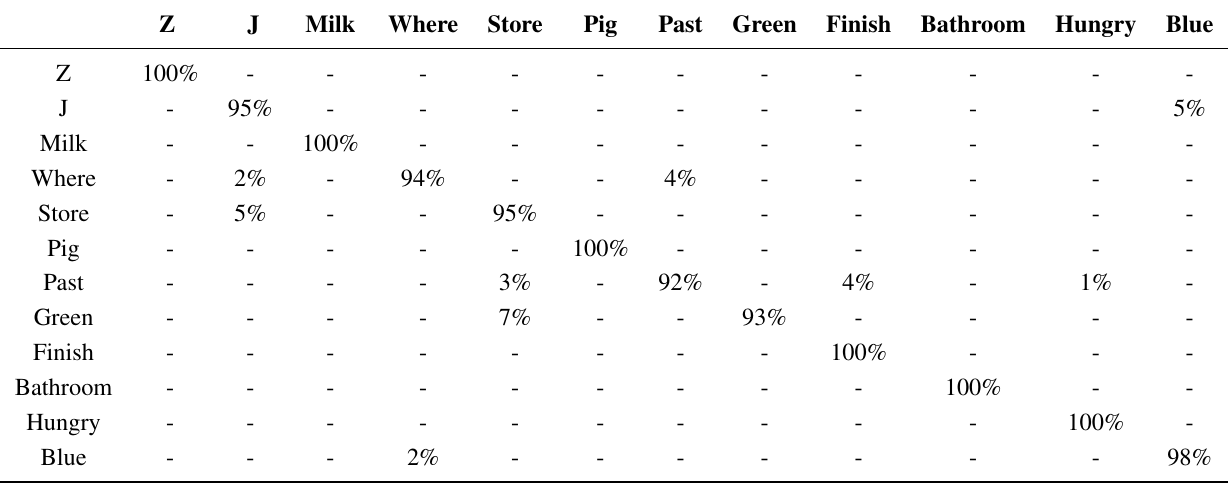
Table 2. Confusion matrix of the MSRGesture3D database results classified by HAGR-D.